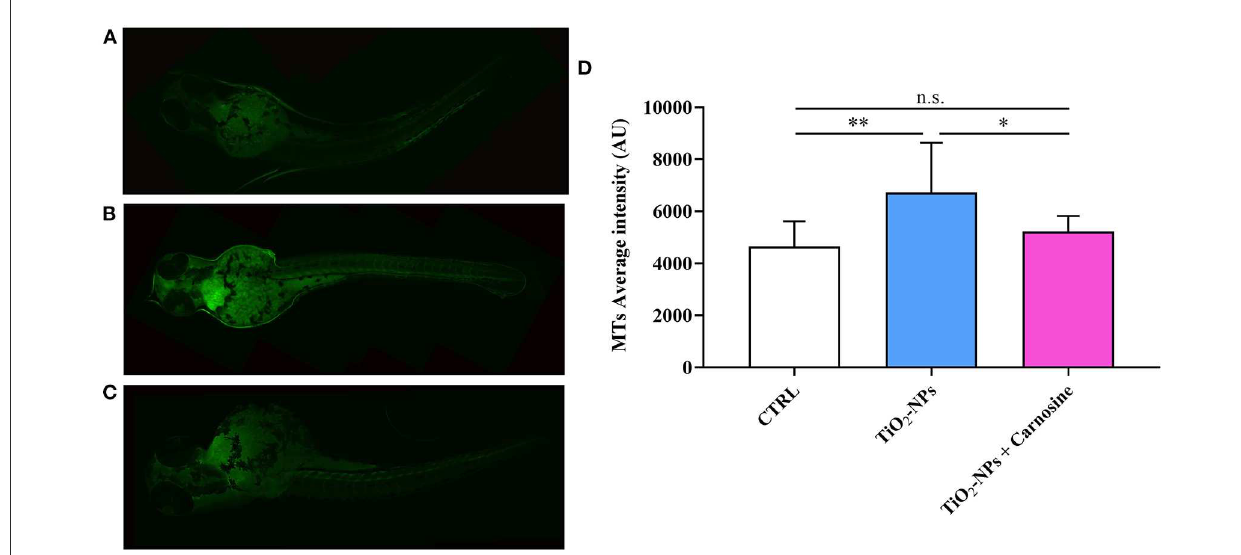
FIGURE7 MTs expression levels in (A) untreated larvae, (B) TiO 2 -NPs-treated larvae, and (C) TiO 2 -NPs-treated larvae in the presence of carnosine 20mM (1h pre-treatment). Carnosine was kept during the exposure to TiO2-NPs. The average fluorescence intensity (AU) of at least 4 values for fixed larva is reported in (D) . SD is represented by vertical bars. *Significantly different, p < 0.05; **Significantly different, p < 0.01; n.s., not